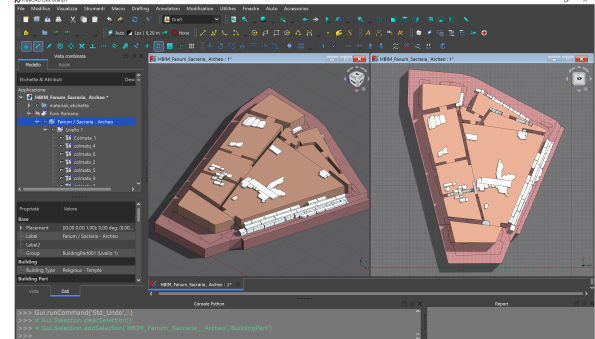
Figure 4 . Parametric model of the archaeological evidences of the excavated Domus Regia.